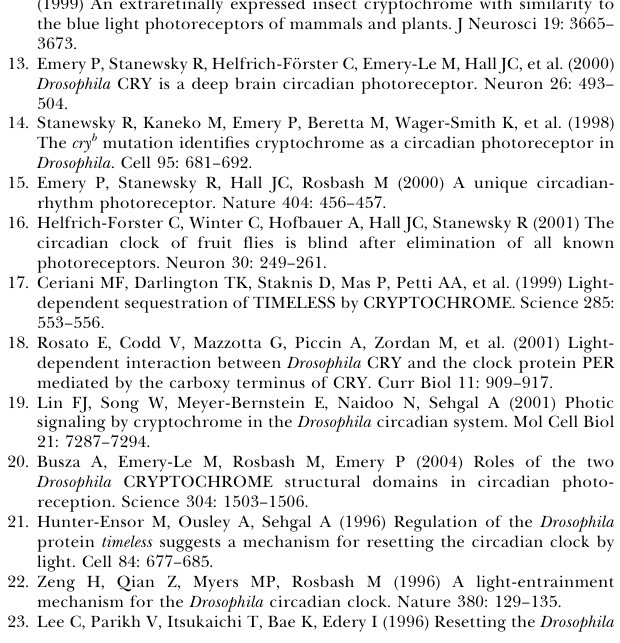
Figure S2. Functional CRY Is Required for HP-Mediated Phase Delays Top and bottom panels show the phase changes observed at ZT15 (A) and ZT21(B), respectively. On the x -axis, the zeitgeber 37 8 C HP or light pulse (LP) is indicated. Phase delays and advances are described in Figure 1A and plotted on the y -axis ( 6 SEM) as negative and positive values, respectively. The genotype of the flies is indicated on the x -axis: the first row shows the transgenes present (a plus sign corresponds to a chromosome without a transgene), whereas the second row indicates the genetic background (wild-type [WT] or cry b ). Found at doi:10.1371/journal.pbio.0050146.sg002 (1.2 MB TIF) Figure S3. CRY Forms a Complex with PERL/TIM at a Constant Temperature of 29 8 C but Not with Wild-Type PER/TIM (A) TMC flies (MYCCRY); per þ (PER þ ), and TMC flies (Myc-CRY); per L (PER-L) were subjected to standard 12:12 light:dark conditions at 29 8 C. Samples were collected at either ZT15 (lane 1) or ZT21(lane 2) for PER þ flies and at ZT18 (lane 3) and CT02 (lane 4) for PER-L and frozen. Head extracts (HE) were immunoprecipitated with antibody to MYC (IP), all as previously described [20]. CRY, PER, and TIM levels were measured by Western blotting. These heat-dependent inter- actions among CRY, TIM, and PER were measured twice with similar